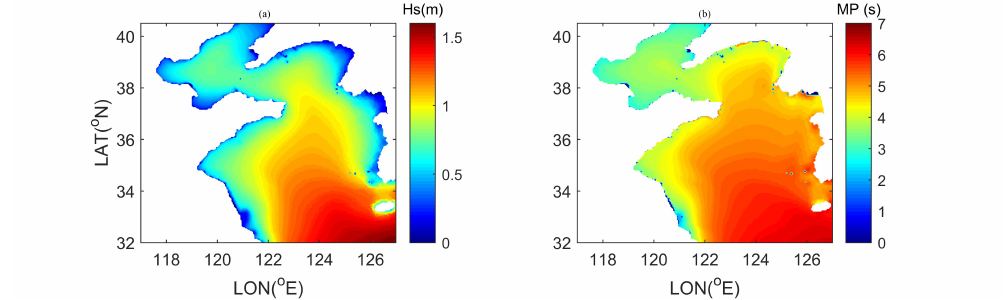
Figure 4. Distributions of mean Hs ( a ) and MP ( b ) based on the hindcast from 1979 to